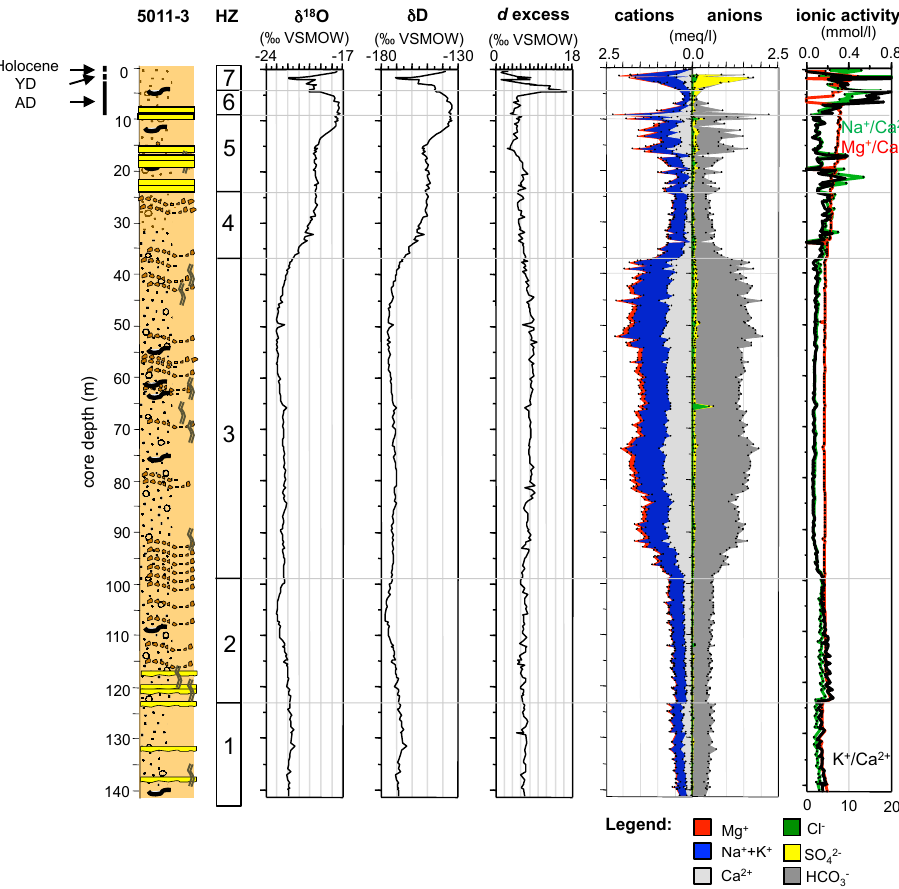
Figure 4. The lithological log of core 5011-3 with stable isotope records ( δ 18 O, δ D, d excess), main cation and anion composition, and ion coefficients. Note: K + / Ca 2 + lower scale; Na + /Ca 2 + and Mg + / Ca 2 + upper